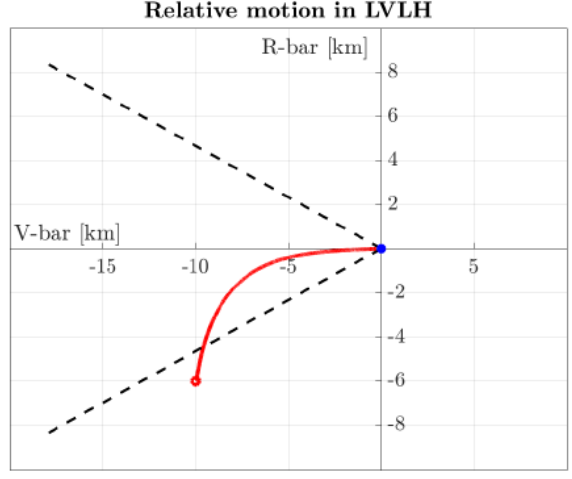
Figure 26. Approaching constraint example.